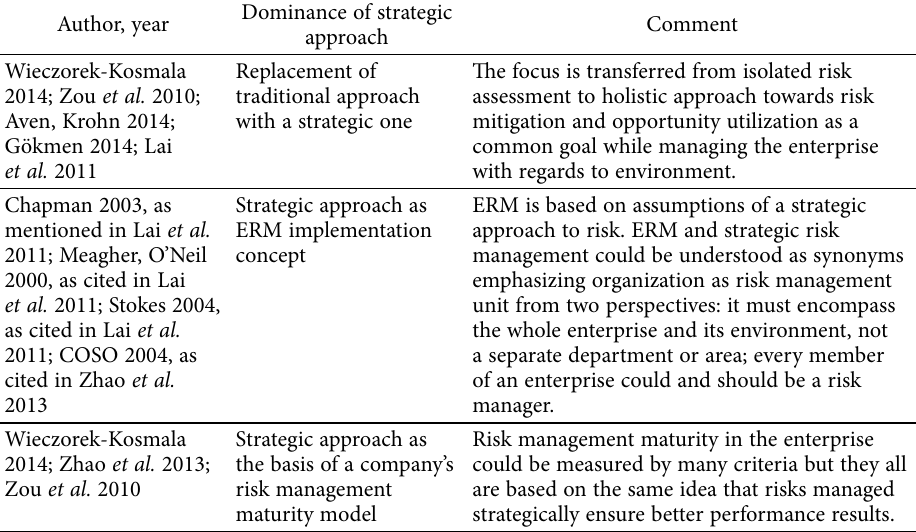
Table 3. Predominance of strategic approach towards risk Author,